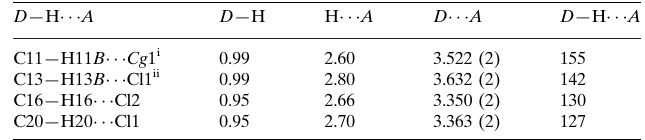
Hydrogen-bond geometry (A˚ , (cid:2)